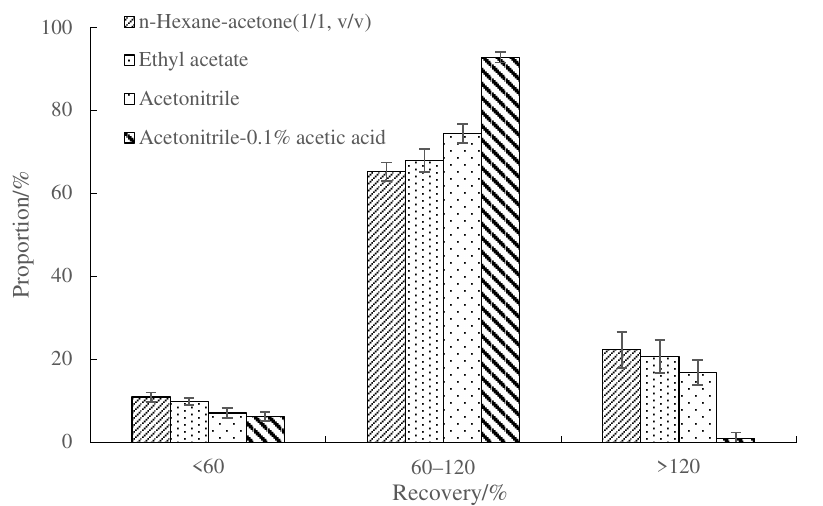
Figure 2. Recovery ranges of pesticides extracted by different solvents.